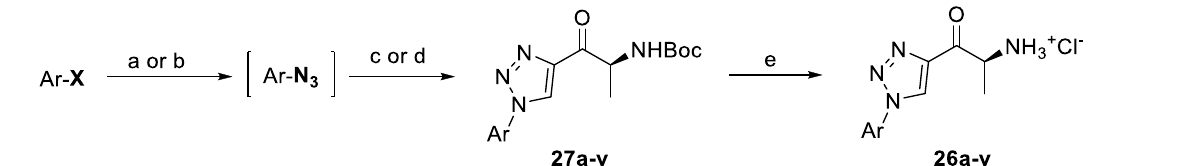
Table 2. Synthesis of triazole derivatives with variation in the aryl moiety.